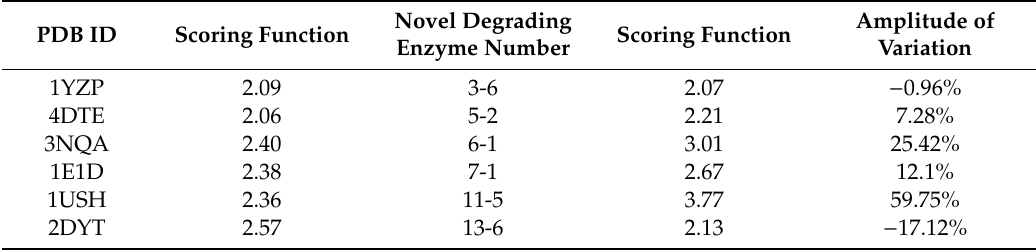
Table 6. Dating function and variation range of degrading enzyme and methanol before and after